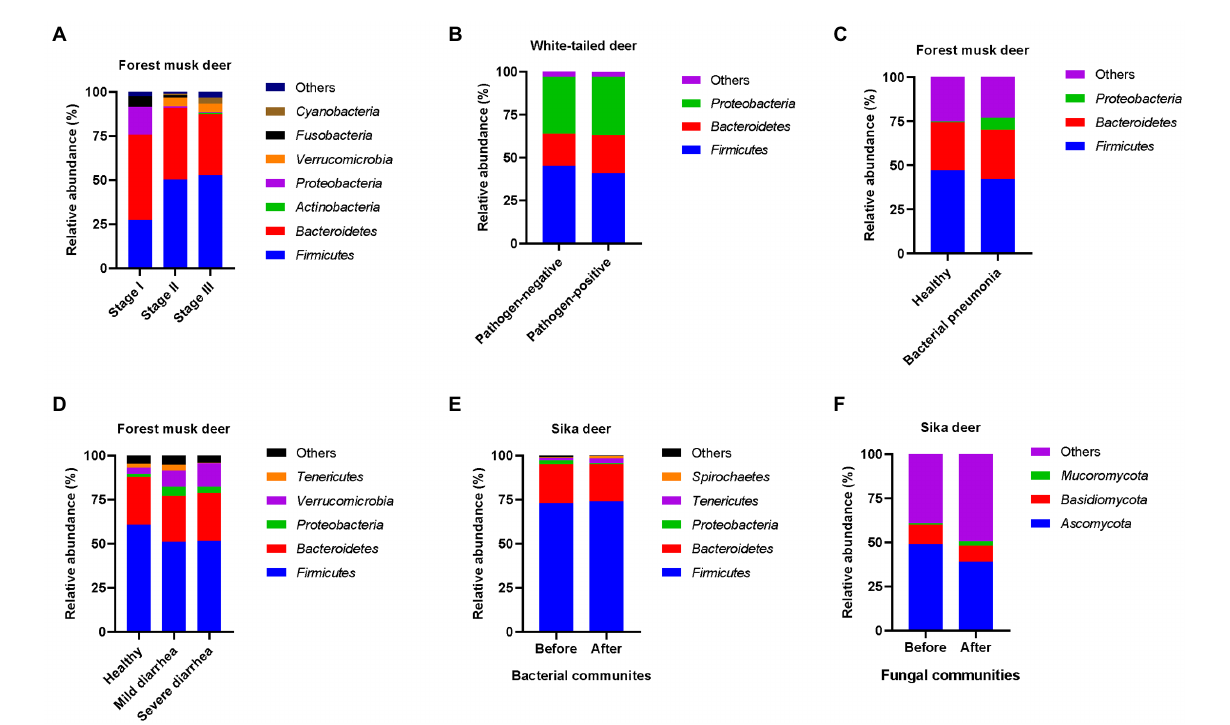
FIGURE 2 Microbial composition of the gut bacterial community of deer species at the phylum level in weaning (A) , pathogen-positive or -negative (B-D) , and antibiotic treatments (E,F) ,